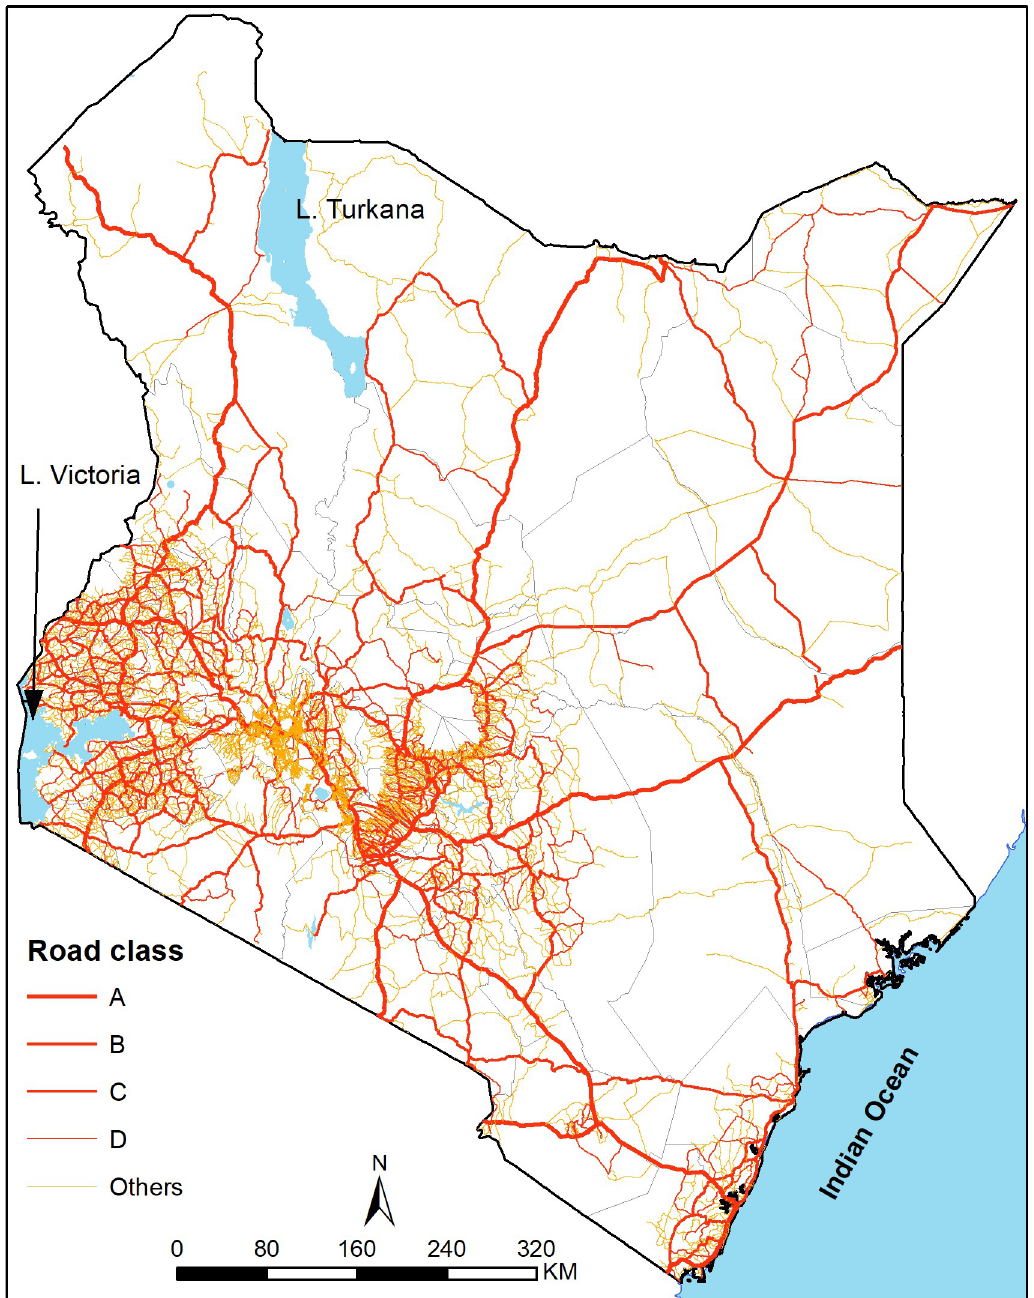
Fig 3. A map of road network in Kenya. Source: